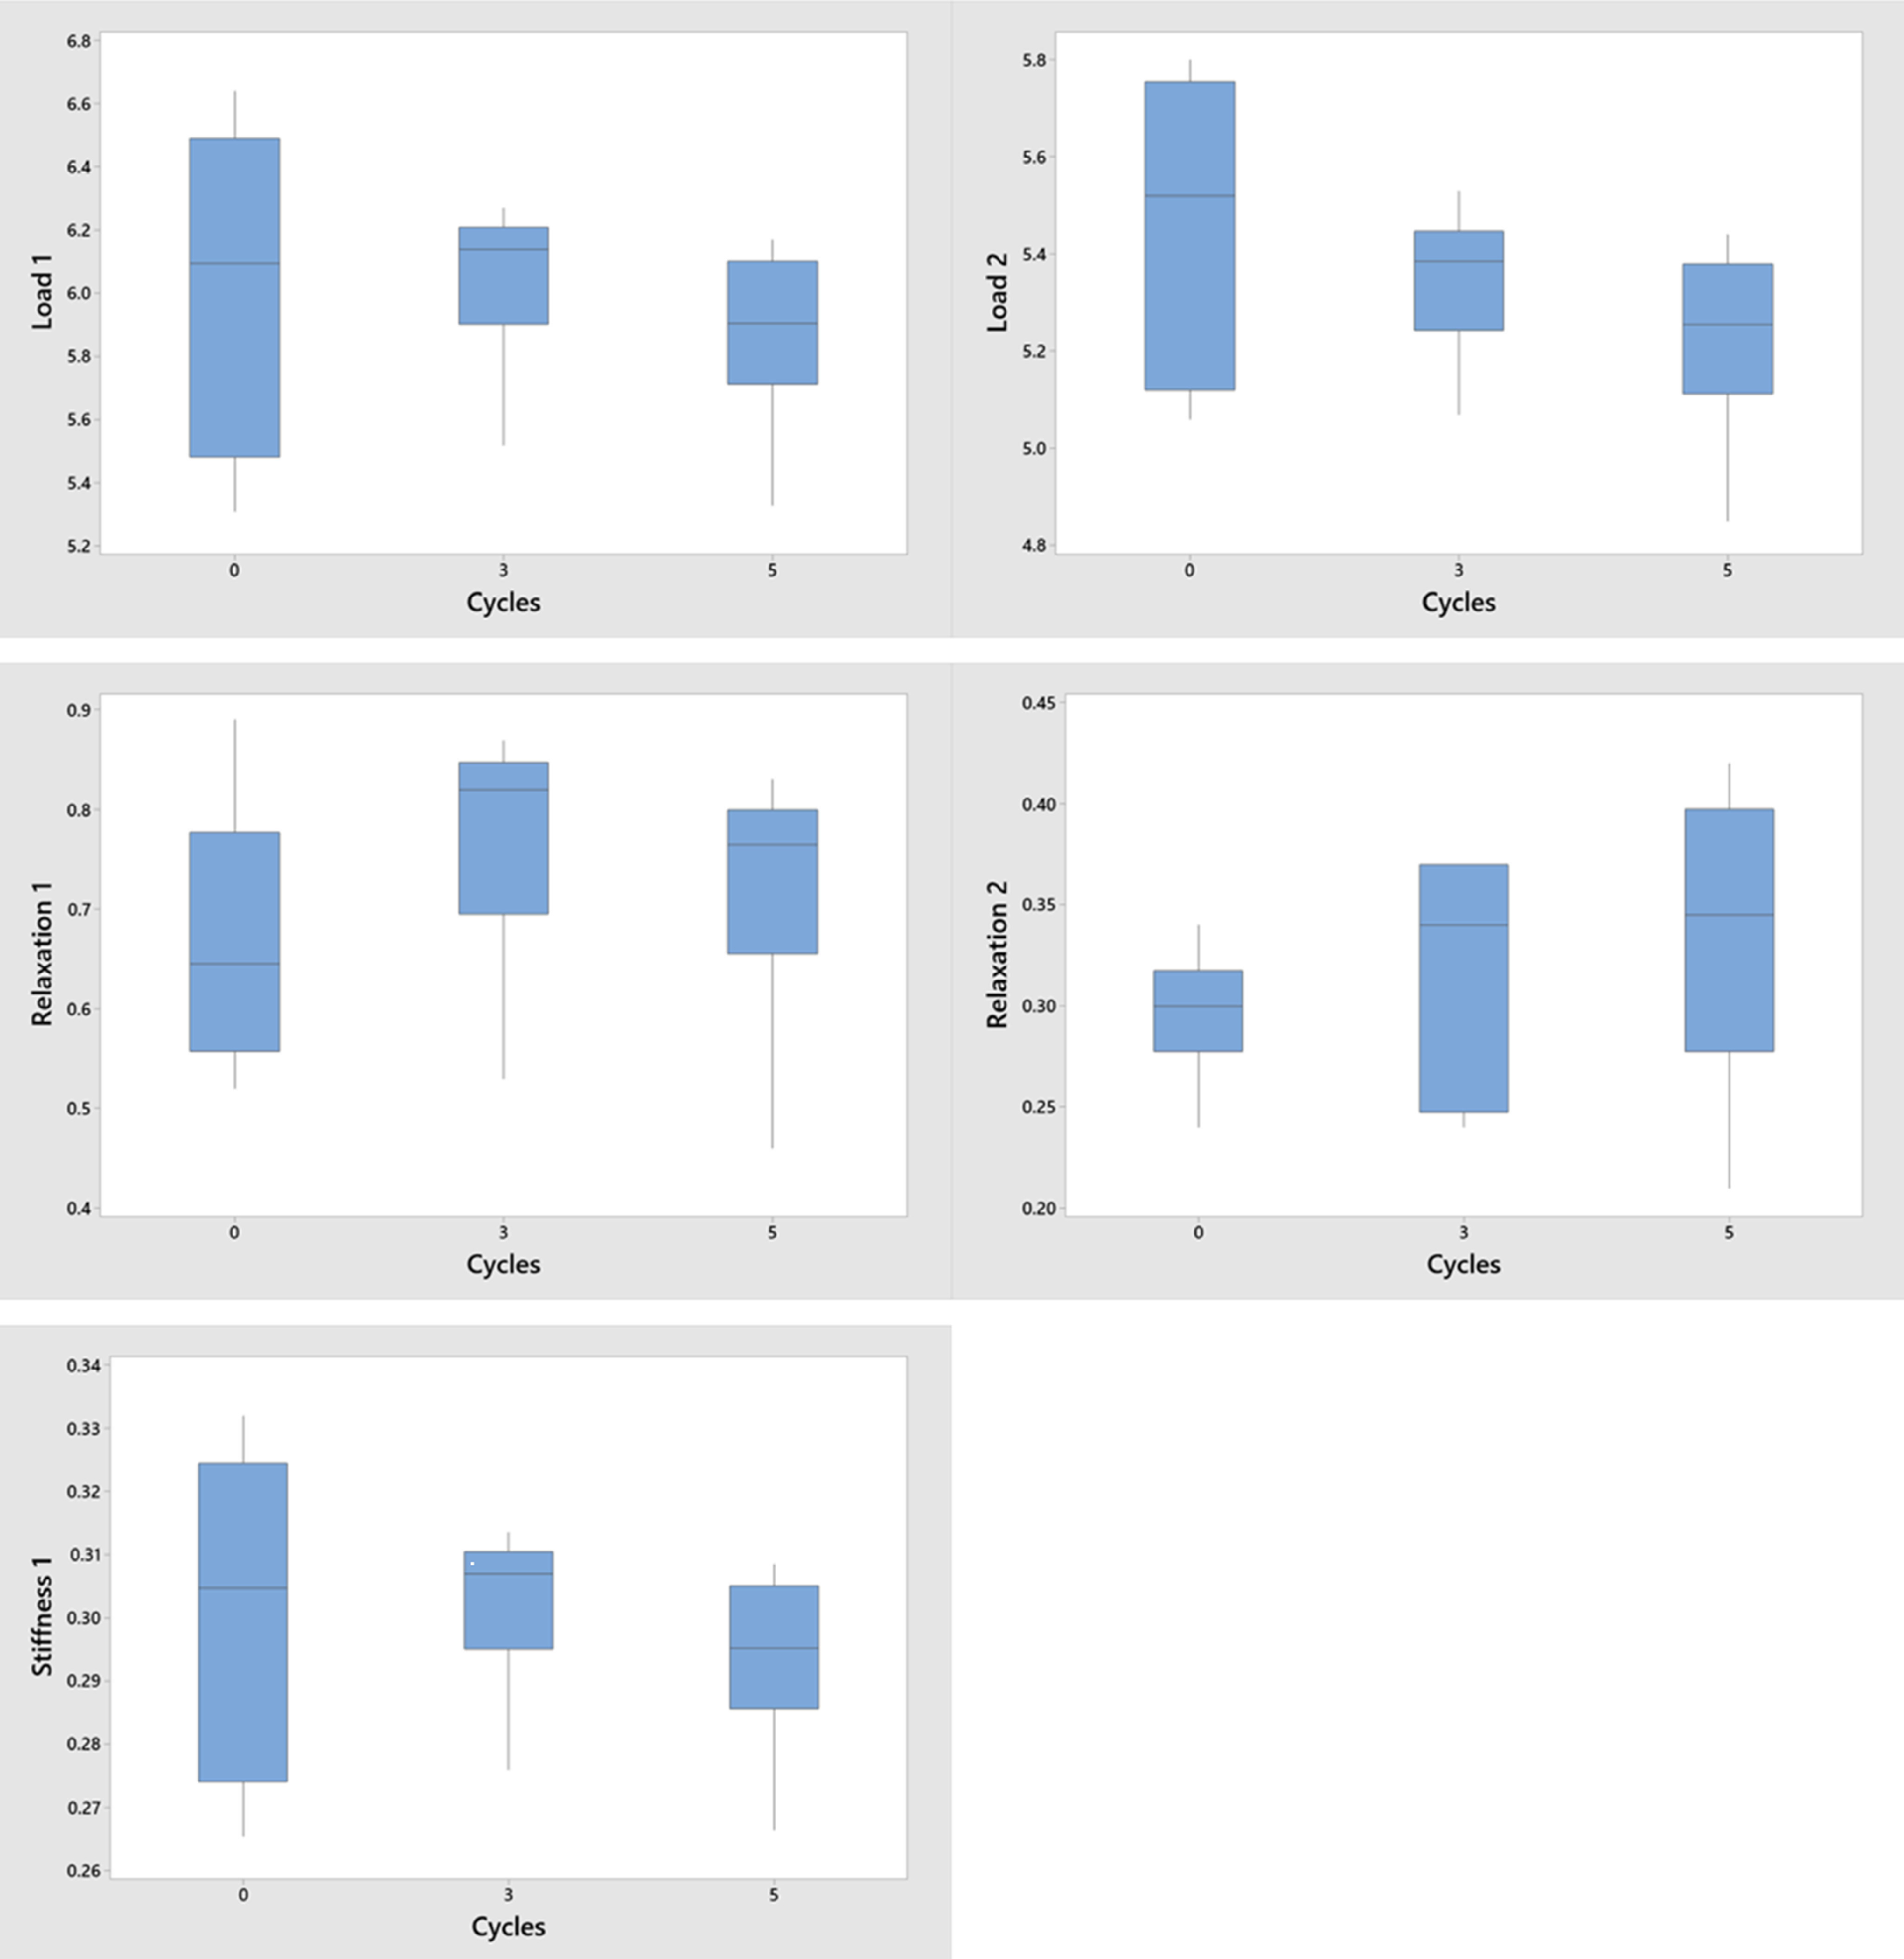
Interval plots for mechanical test variables as a function of disinfection cycles. The horizontal line is the median. The box indicates the interquartile range. The whiskers extend to the minimum and maximum values.